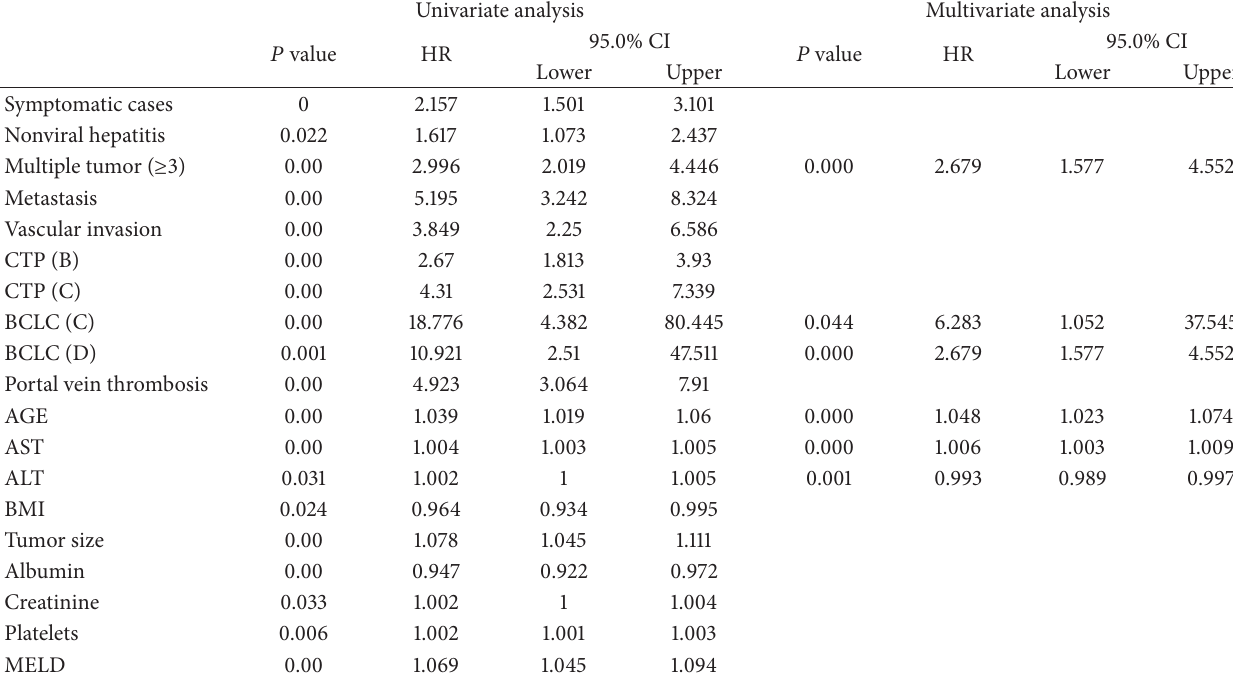
Table 6: Univariate and multivariate cox regression analysis of variables associated with poor survival in HCC